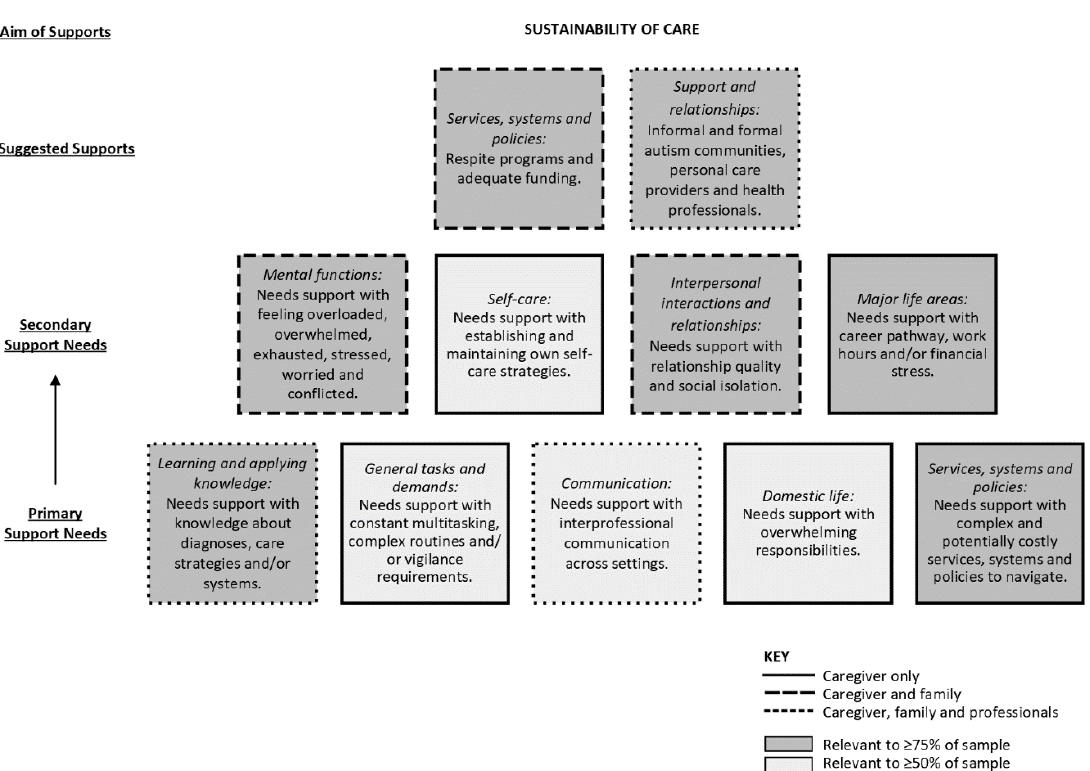
Figure 3. Hierarchical outcome space for caregivers and others, illustrating two interacting levels of support needs (primary and secondary) that can be addressed through a combination of two types of suggested supports to achieve the overall aim for the caregivers and others.